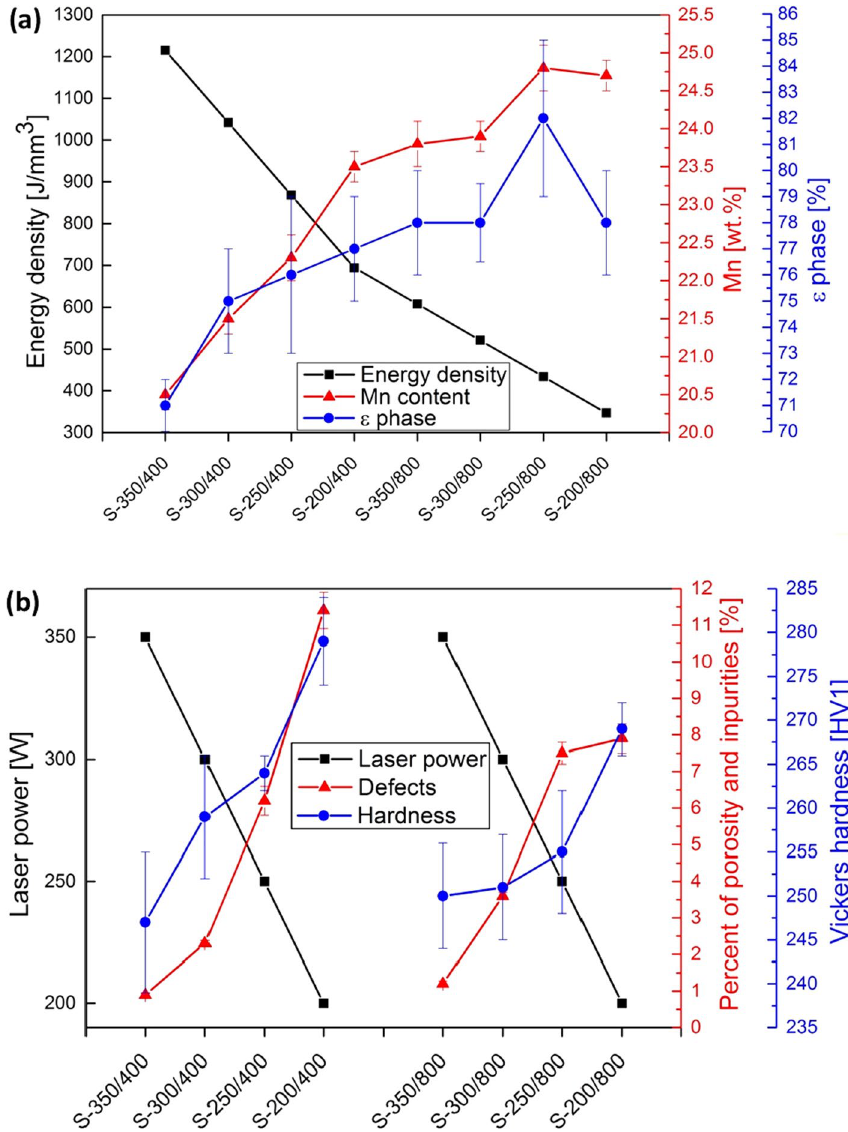
Figure 2. Correlation of the concentration of Mn and ε phase with the LPBF parameter E ( a ) and correlation of the percentage of impurities and material hardness with the LPBF parameter P ( b